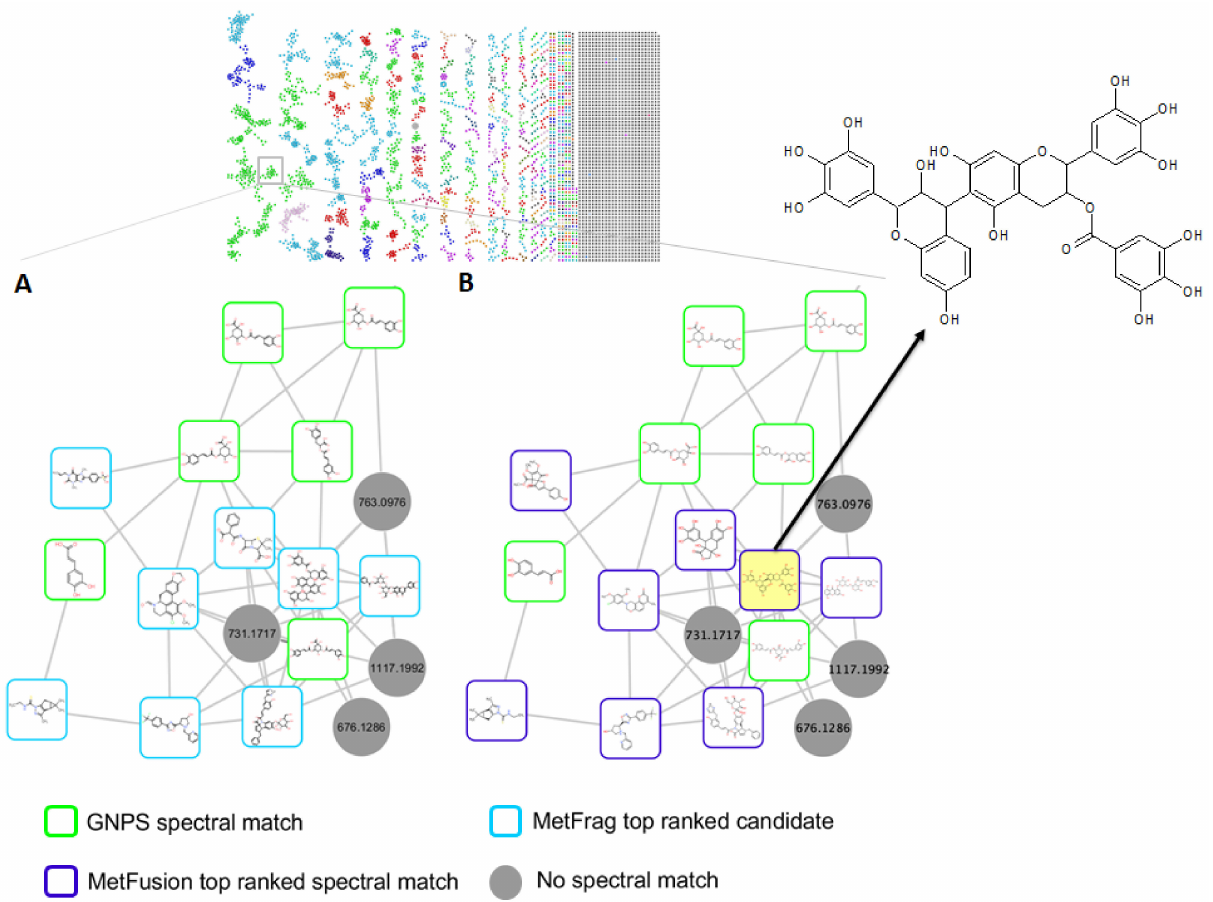
Figure 4. Molecular network family cluster of the carboxylic acid and derivatives chemical compound class containing GNPS spectral library and NAP propagated annotations from maize leave extracts analyzed in positive electrospray ionization (ESI+). ( A ) Cluster of polyphenolic flavanol compounds matched with GNPS spectral library (green square-shaped nodes), top ranked predicted NAP MetFrag candidate structures (blue square-shaped nodes) and no spectral match (grey nodes) annotations; ( B ) Cluster of polyphenolic flavanol compounds matched with GNPS spectral library (green square- shaped nodes), NAP MetFusion top ranked candidate structures, with epigallocatechin-(4 β ->8)- epigallocatechin-3-O-gallate ( m / z 763.1514) compound highlighted in yellow, (purple square-shaped nodes) and no spectral match (grey nodes)